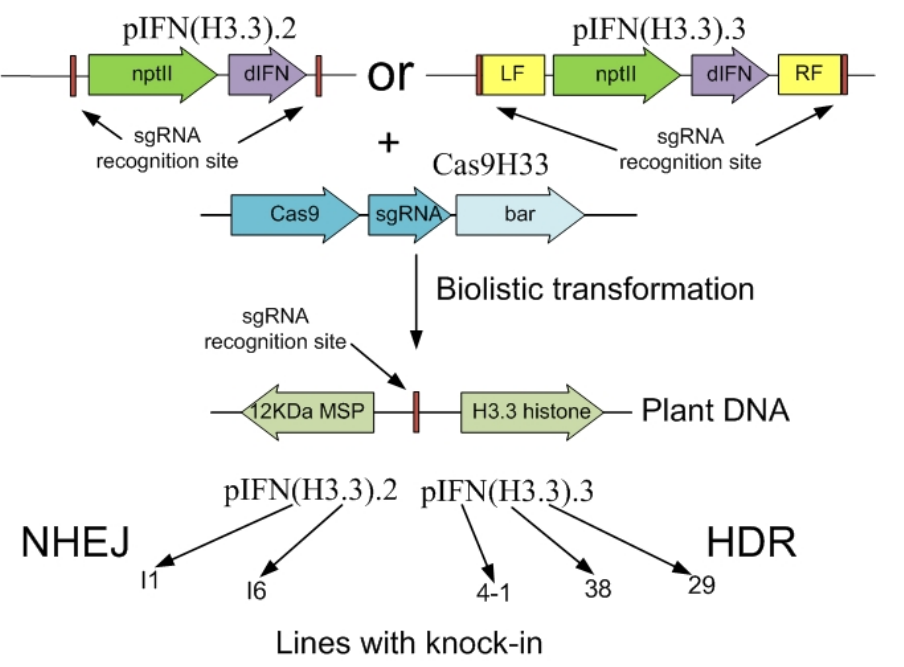
Figure 1. The general scheme for obtaining lines with knock-in. Designations: nptII, neomycin phosphotransferase II gene providing plant cell resistance to kanamycin; dIFN, DNA sequence encoding the target dIFN protein; LF and RF, left and right flanking sequences homologous to the corresponding regions in the A. thaliana genome; sgRNA—single guide RNA gene; Cas9— endonuclease Cas9 gene; bar—phosphinothricin resistance gene; 12 KDa MSP—12 kDa subunit of microsomal signal peptidase (At4g40042) gene of A. thaliana ; H3.3 histone—histone H3.3 gene HTR5 (At4g40040) of A. thaliana ; NHEJ—non-homologous end joining; HDR—homologous directed repair. Table 2. Mutations from the left (LF) and right (RF) flanking sequences in the studied cell lines. Cell